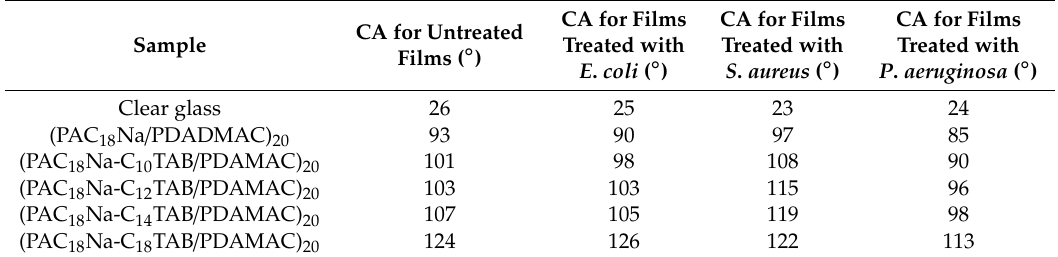
Table 3. The contact angle (CA) values for untreated films and films subjected to microbial attack with positive and negative bacteria.